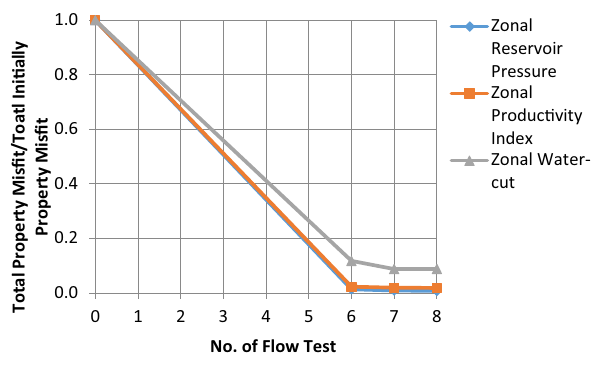
Fig. 8 The total property misfit reduces with an increasing number of flow